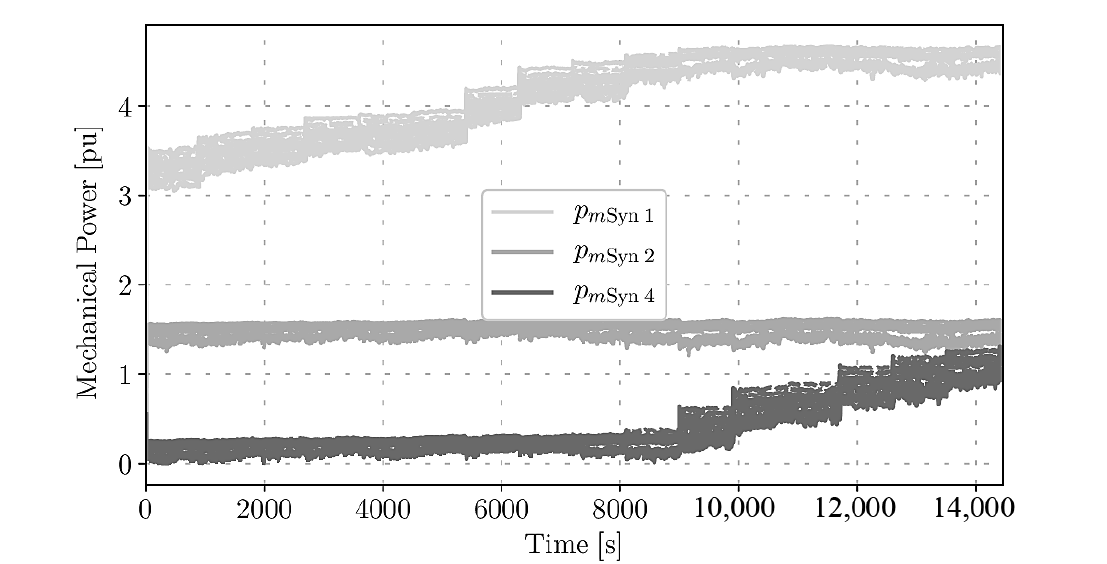
Figure 11. Trajectories of ω COI for 15-min time period and alternative SUC model.